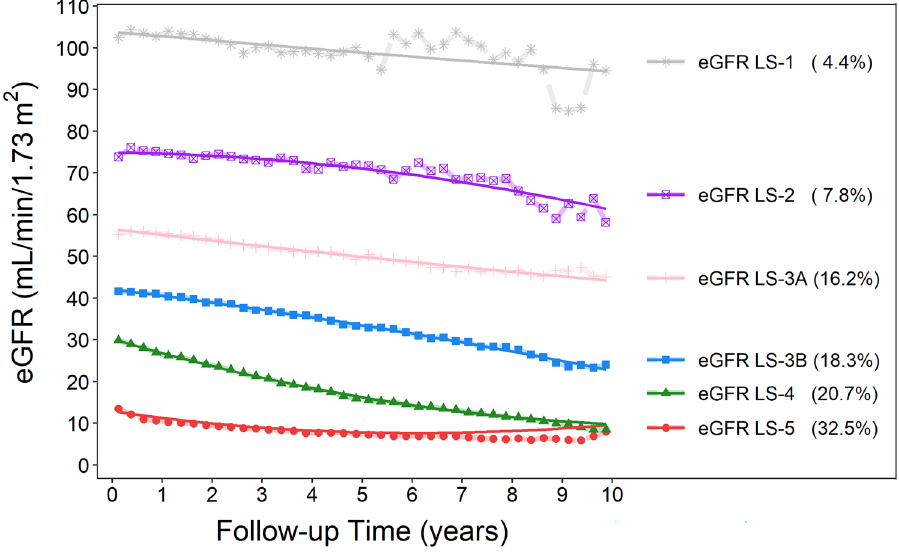
Figure 1. Longitudinal stages of eGFR trajectory defined by using GBTM according to serial quarterly average levels of eGFR over the CKD course. The solid line is the averaged estimated trajectory, and the points represent the averaged observed